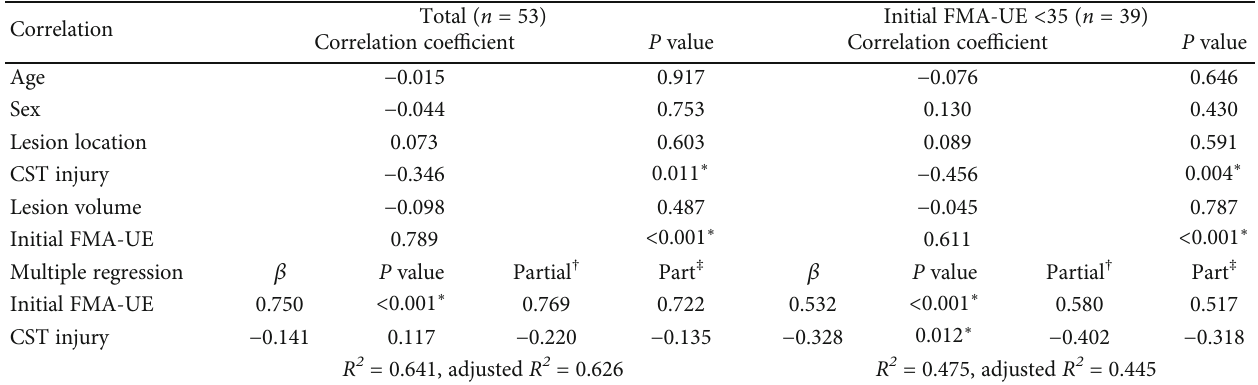
Figure 2: Follow-up Fugl-Meyer assessment of the hemiplegic upper extremity (FMA-UE). (a) Linear regression between corticospinal tract (CST) injury and follow-up FMA-UE scores. The symbols indicate the same patient clusters as those shown in (b). The solid line is the regression line, and the dashed line is the regression line after the exclusion of patients with an initial FMA-UE score of ≥ 35 ( ■ ). (b) Hierarchical clustering between initial and follow-up FMA-UE scores shows three clusters ( ■ , □ , and × ). The solid line is the line of identity. Table 2: Correlation and multiple regression analyses between FMA-UE and other